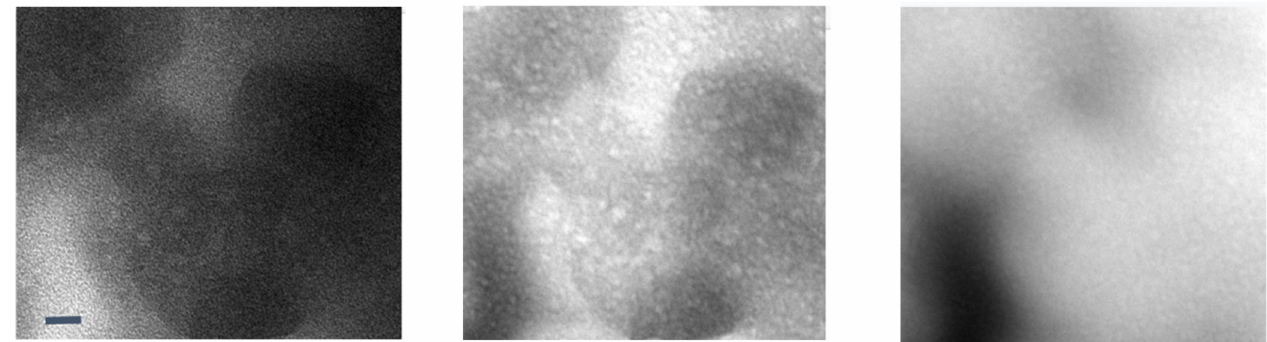
Figure 6. Low-loss EFTEM image series of a soluble fullerene/polyethylene oxide-based lithium-conducting solid electrolyte. From left to right: 0 eV, 30 eV, and 62 eV. The images show fullerene aggregates (white dots) with the highest contrast at an energy loss of 30 eV. These are unpublished images related to the work published in [79]. The scale bar is 10